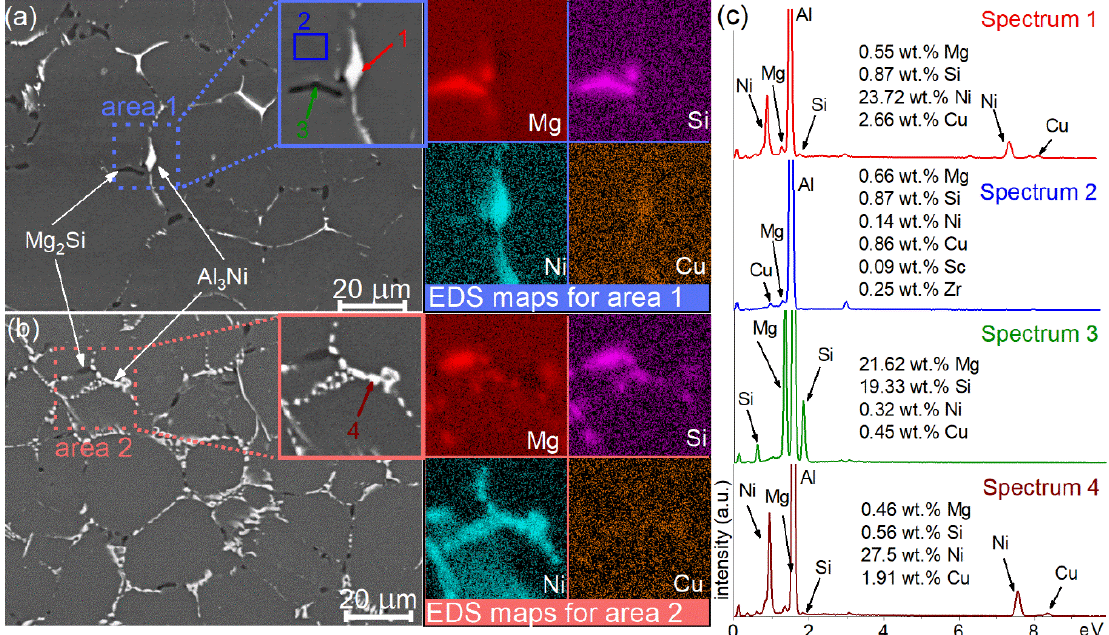
Figure 4. SEM images for the ( a ) alloy 1 (Al-1.2Mg-0.7Si-1.0Cu-0.5Ni) and ( b ) alloy 2 (Al-1.2Mg-0.7Si-1.0Cu-2Ni) after the two-step homogenization and corresponded to EDS elemental distribution maps captured from the area 1 in ( a ) and area 2 in ( b ); ( c ) the EDS spectrums corresponded to the area marked-up in insert in ( a , b ).